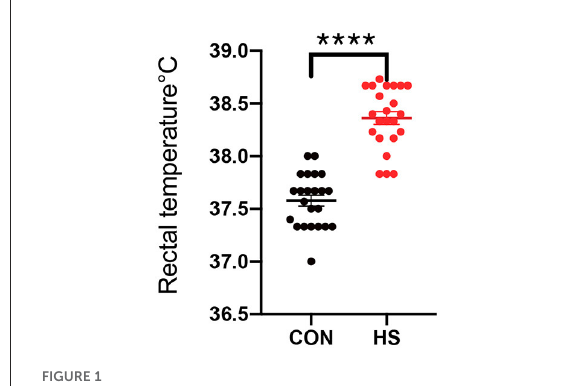
FIGURE1 Rectal temperature of female rabbits ( n = 23 per group) in HS group and CON group. CON indicates CON group and HS indicates HS group. ****indicated statistically significant difference.